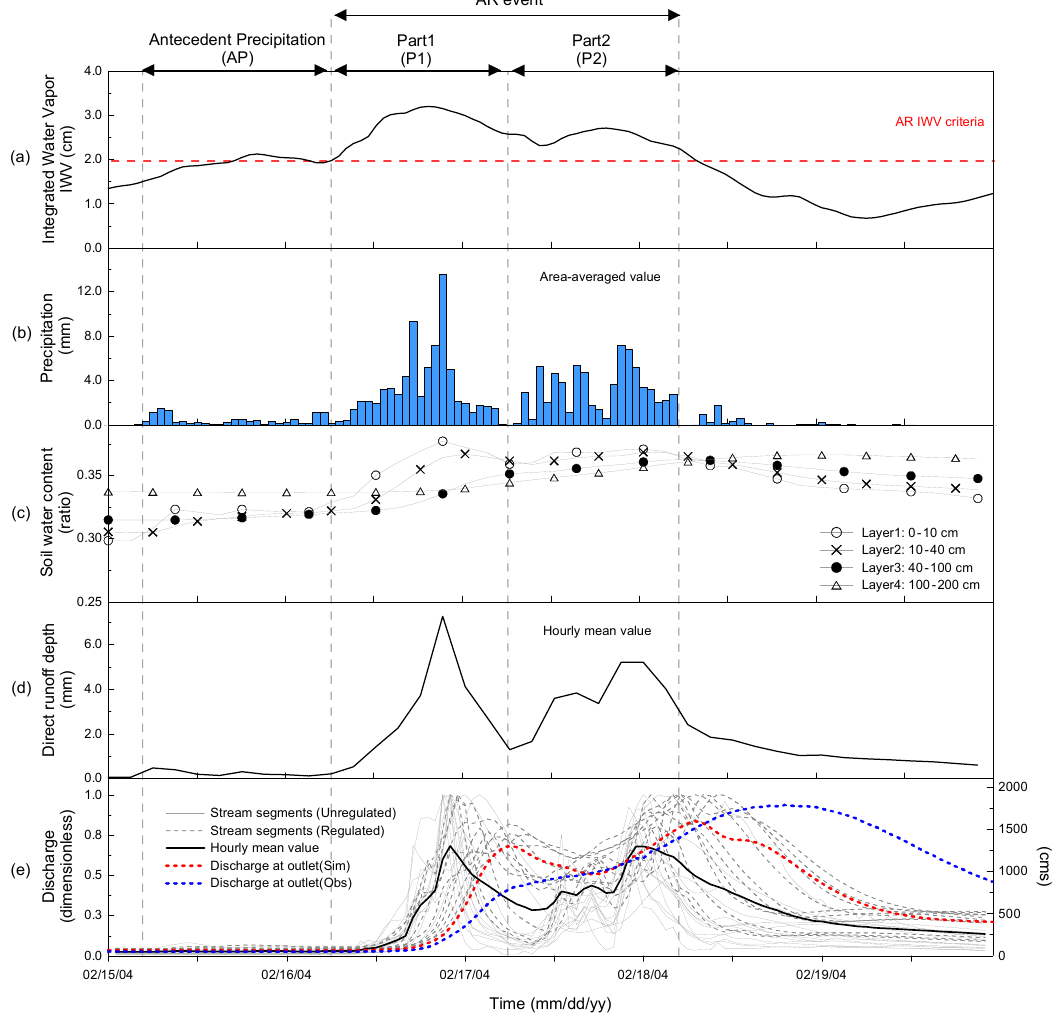
Figure 7. Time-series results obtained with the NWM (15–19 February 2004). The results shown in the figure include the integrated water vapor (cm) ( a ), precipitation (mm) ( b ), soil water content for four layers ( c ), direct runoff depth (mm) ( d ), and streamflow discharge ( e ). The three periods, AP, P1, and P2, indicate the antecedent precipitation time just before the AR event and two parts of the AR event. Simulated results for ( a – d ) are area-averaged values over the entire domain, and ( e ) shows the simulated discharge for USGS gauges in each stream.